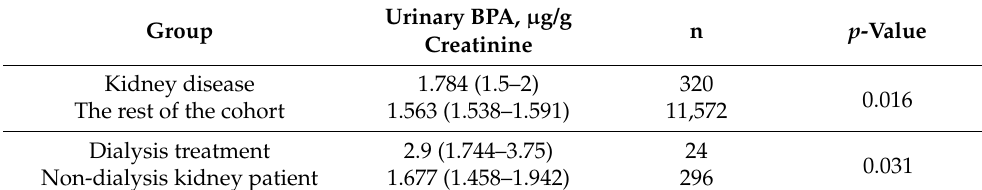
Table 2. Urinary BPA/creatinine in diabetic and kidney patients vs. healthy population. Data were represented using the median (95% CI). For statistical analysis, Mann–Whitney test was performed.